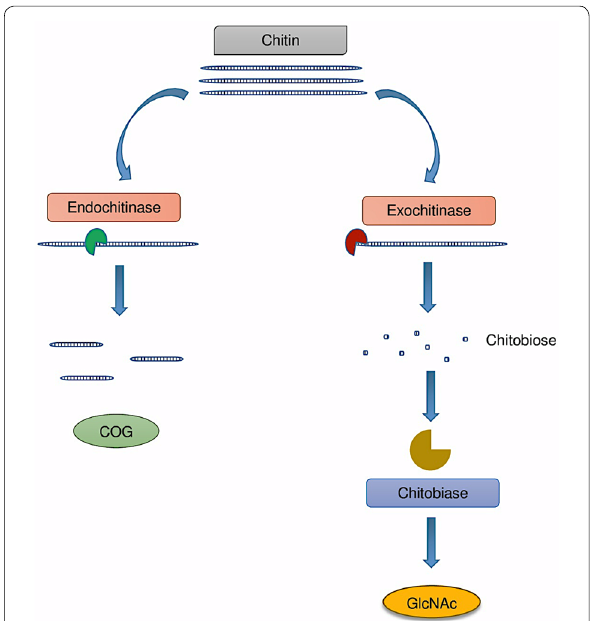
Fig. 5 Enzyme system for degradation of chitin into COG, chitobiose and